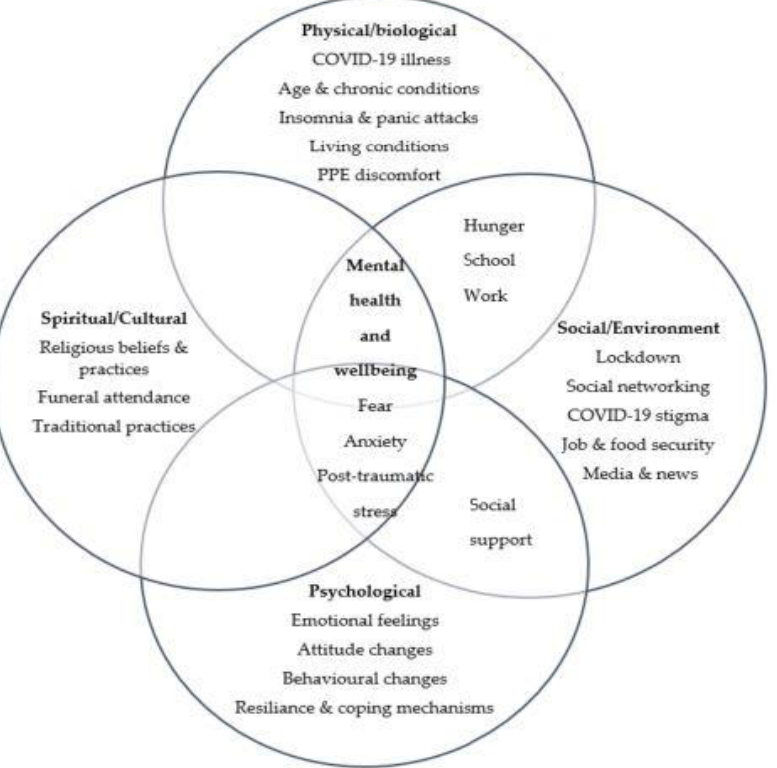
Figure 2. The intersection of mental health challenges among participants during the COVID-19 pandemic and lockdown in South Africa.